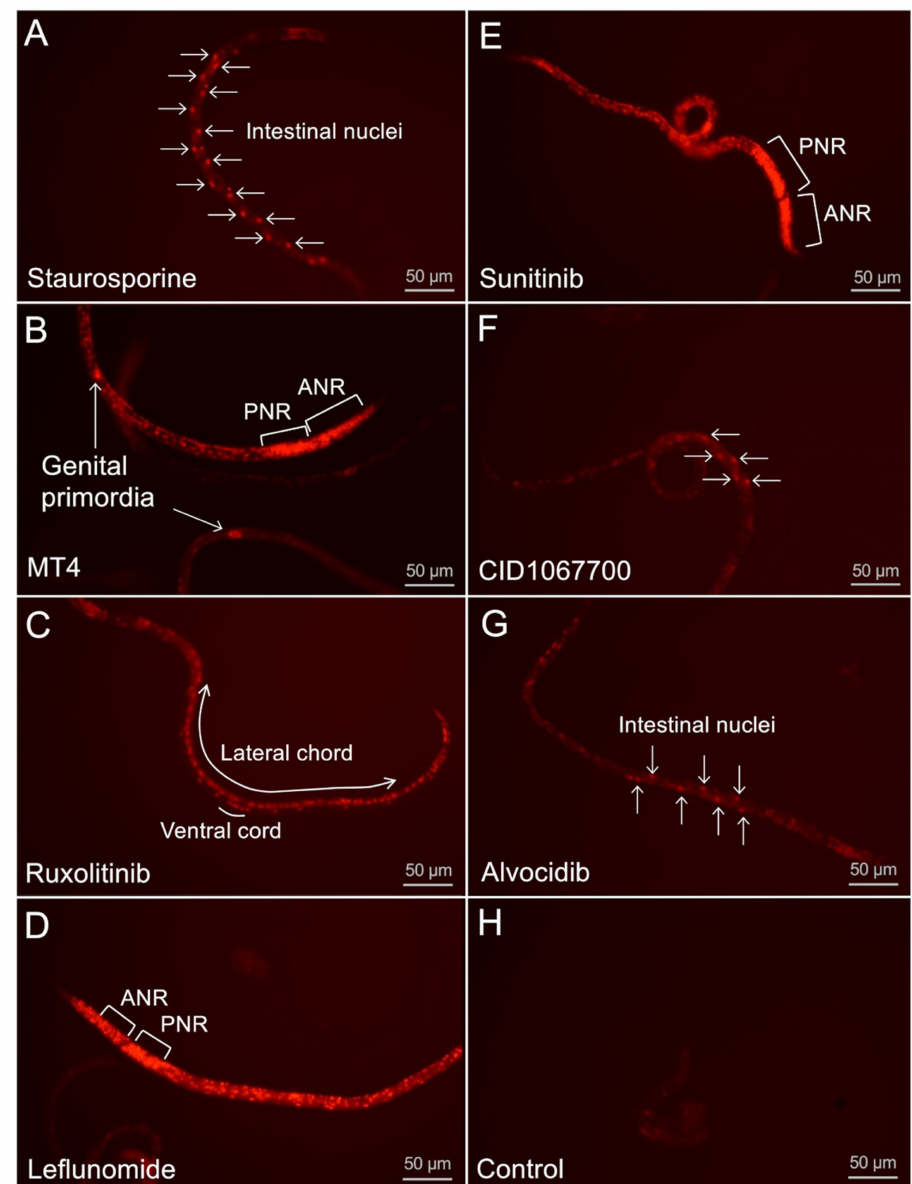
Figure 5. L4-stage H. contortus propidium iodide (PI) cell death staining (20 × inverted scope) following 2 days of treatment with ( A ) staurosporine (25 µ M), demonstrating an intestinal-focused cell death pattern; ( B ) MT4 (500 µ M) demonstrating death of genital primordia cells, not visible in BB staining; ( C ) ruxolitinib (500 µ M), demonstrating cell death along the lateral line as well as cells in the ventral cord; ( D ) leflunomide (500 µ M), demonstrating widespread cell death including staining of both the ANR and the PNR (PNR is not visible in BB live-cell staining); ( E ) sunitinib (500 µ M), demonstrating widespread cell death; ( F ) CID1067700 (500 µ M), demonstrating an intestinal-focused cell death pattern; ( G ) alvocidib (500 µ M), demonstrating staggered intestinal nuclei patterning, and ( H ) controls, demonstrating a lack of cell death in untreated L4